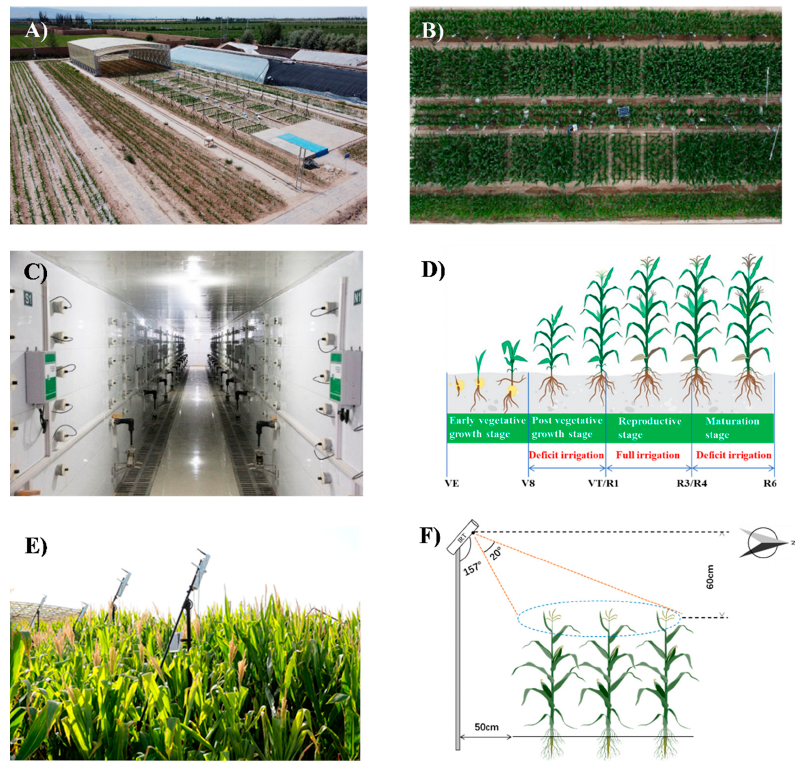
Figure 1. Overview of the experimental area and design. ( A ) a panoramic view of the mobile electric rain-shelter facility and experimental area; ( B ) two maize genotypes (XY335 and ZD958) are planted in 24 non-weighing lysimeters made of concrete, each with an area of 5.6 m 2 (2.8 m × 2 m) and a depth of 1.6 m; ( C ) underground picture of 24 non-weighing lysimeters; ( D ) the schematic diagram of four growth stages of maize, and water treatments at each stage. In the figure, VE, V8, VT, R1, R3, R4, and R6 represent the stage of emergence, the 8th leaf, tasseling, silking, milky ripening, waxy ripening, and physiological maturation, respectively; and ( E , F ) the actual layout and schematic diagram of monitoring canopy temperature using the IRT